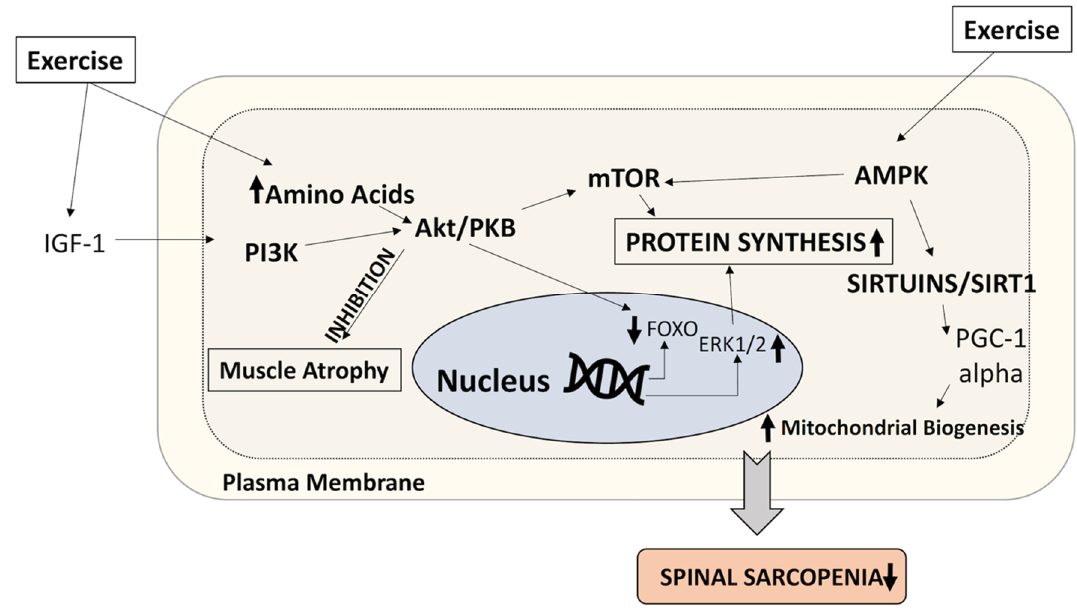
Figure 4. Mechanistic insights into spinal sarcopenia. During aging, the activities of Akt, IGF-1, and AMP-activated protein kinase (AMPK) are reduced. During exercise, increased amino acid levels induce the activity of these components to increase protein synthesis and mitochondrial biogenesis, thereby reducing spinal sarcopenia.